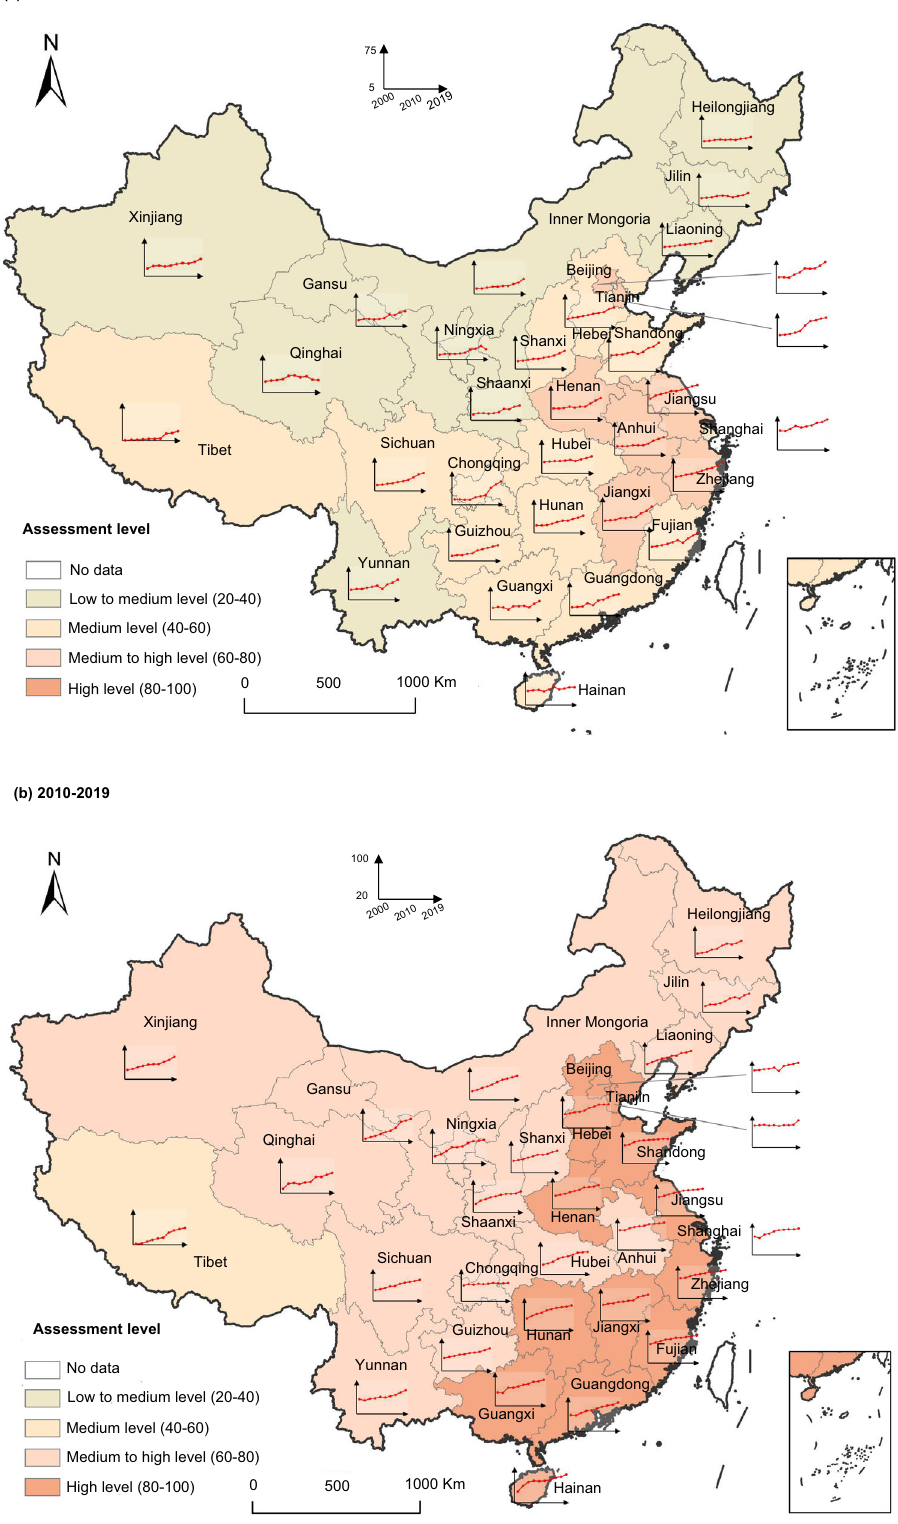
Fig. 4 Urban-rural human settlements quality values across space and its time trend in 31 regions. a Trends of human settlements ’ quality values from 2000 to 2009; b Trends of human settlements ’ quality values from 2010 to